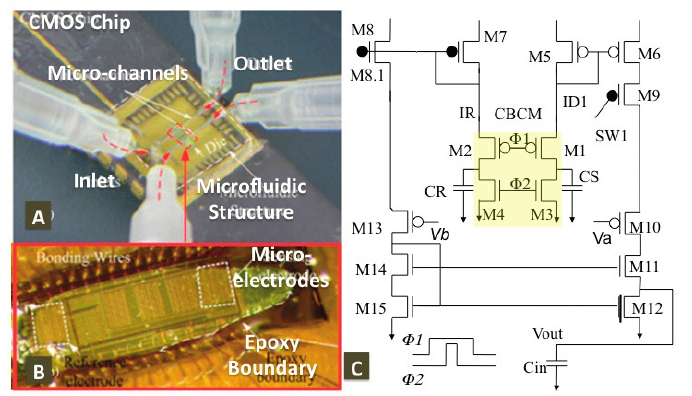
Figure 13. Core-CBCM Capacitive Sensor: photograph of ( A ) Die including ( B ) an array of three sensing capacitances and Integrated microfluidic CMOS system and ( C ) Core-CBCM Capacitive interface circuit (Reproduced with permission from IEEE